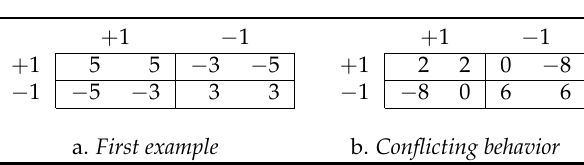
Table 6. Conflicting